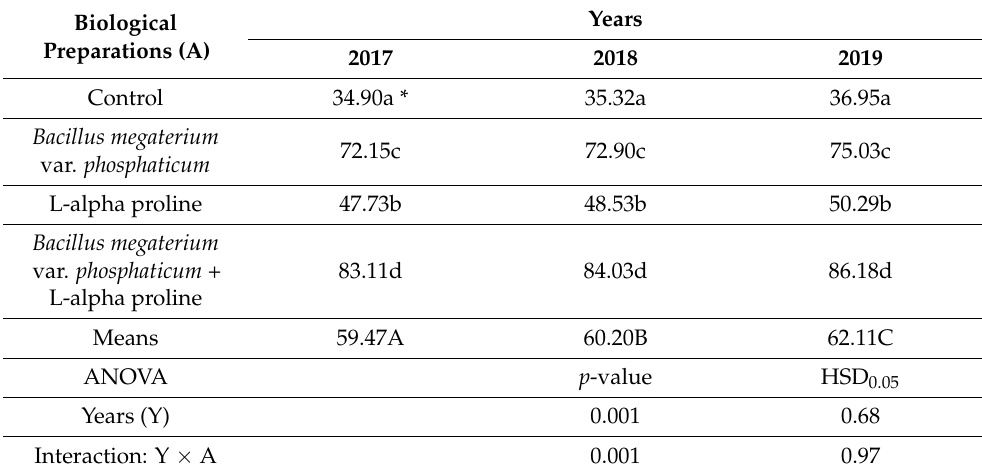
Table 4. Fe content in spring wheat grain depending on the biological preparations used in 2017–2019, mg · kg − 1